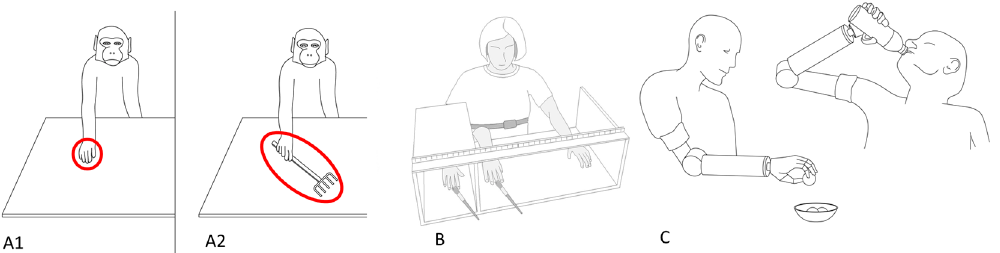
Figure 1. Embodiment and body ownership examples. ( A1 ) Hand-related neuronal populations that normally react only to visual stimuli near the hand ( A2 ) after repeated tool use and show similar activation patterns for the area surrounding the tool. ( B ) The classic rubber hand illusion show how artificial objects, using proper stimulation procedures, can be experienced as part of our own body. ( C ) The appropriate combination of training and features of prosthetic devices can lead to their integration into body representations, allowing for effective interaction with one's body and environment.